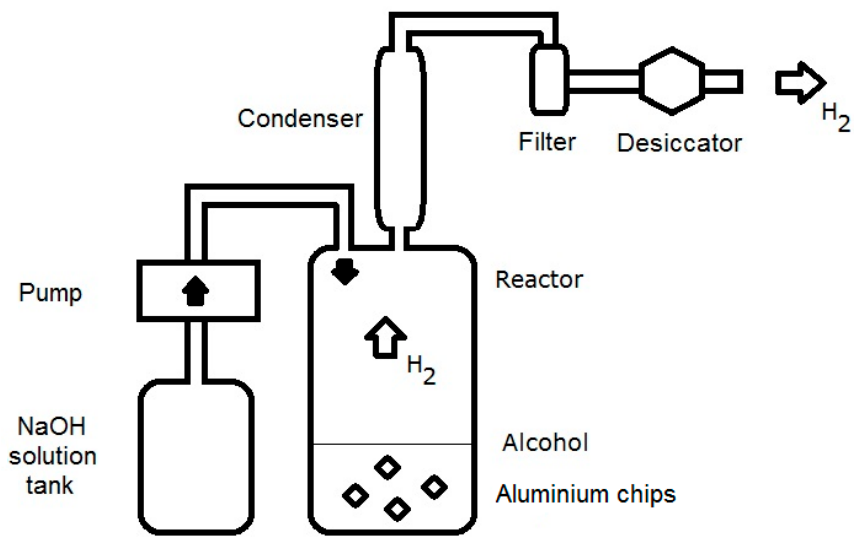
Figure 2. Draft of the experimental equipment used for the production of hydrogen.